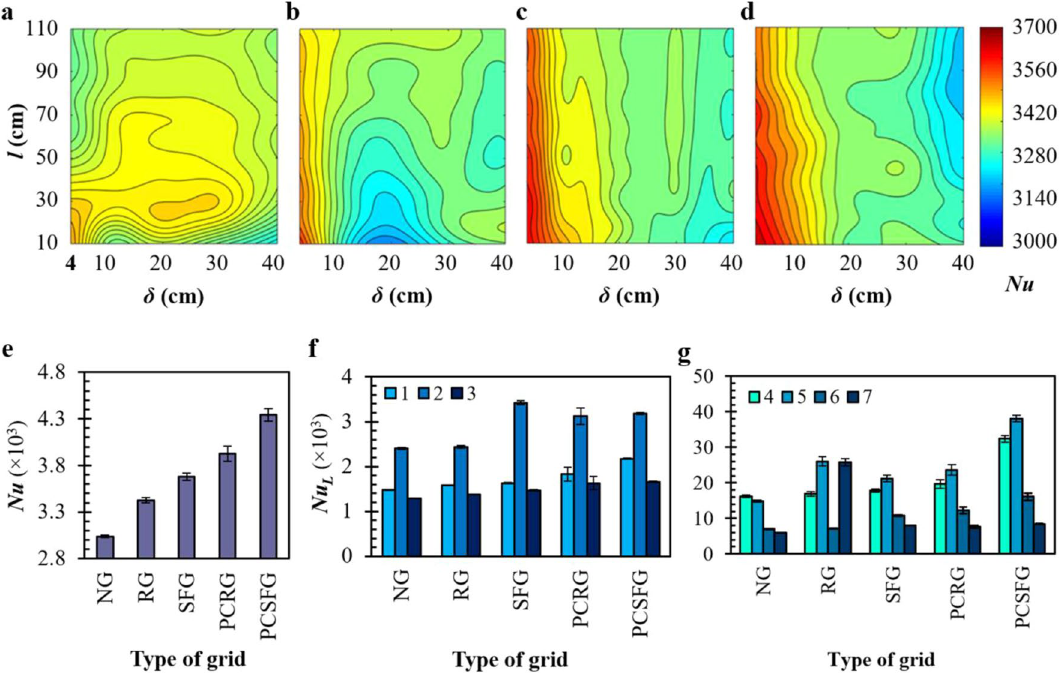
Figure 4. Top, the numerical 2D Nu contour plot induced by ( a ) RG, ( b ) PCRG, ( c ) SFG and ( d ) PCSFG as a function of l against δ . Bottom, various grid empirically induced ( e ) Nu , along with the Nu L of ( f ) base section and ( g ) mid-fin section of plate-fin heat